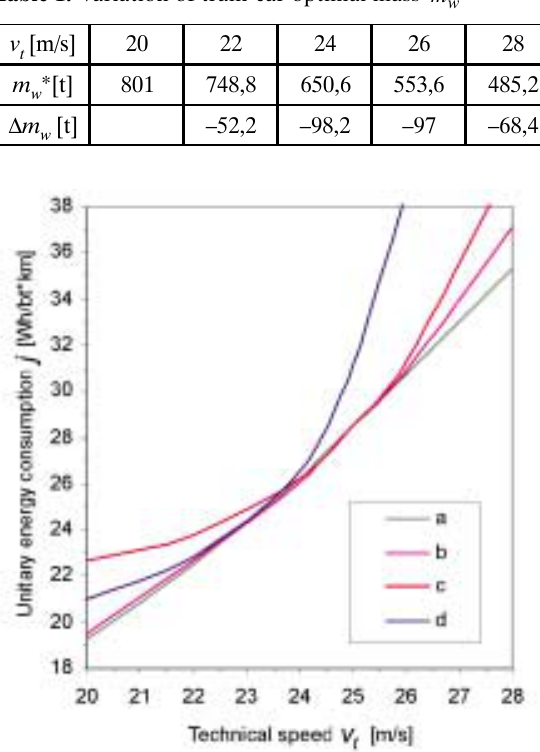
Fig 6. Variations of unitary energy